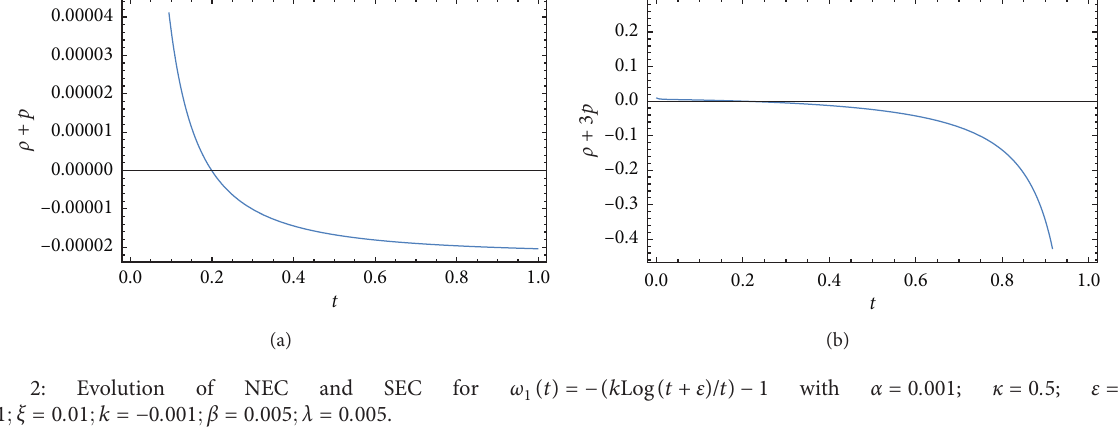
2: Evolution of NEC and SEC for ω